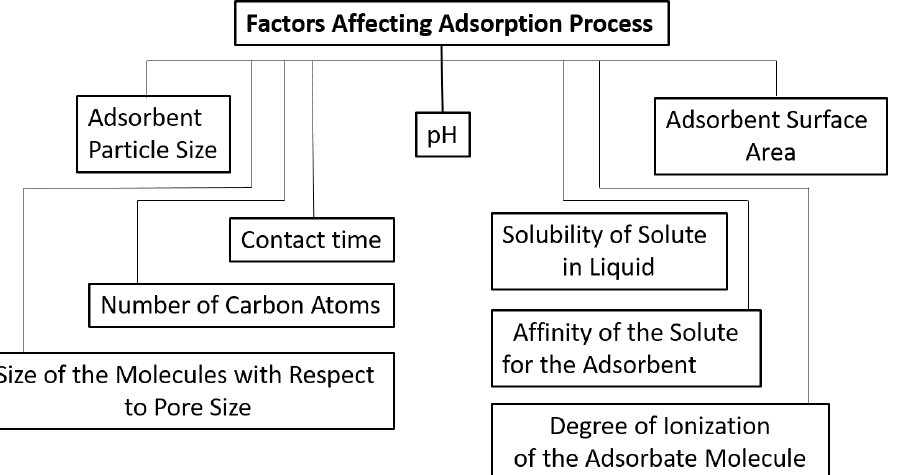
Figure 1. The most important factors affecting the adsorption process (adapted from: Muftah H. El-Naas [16]).